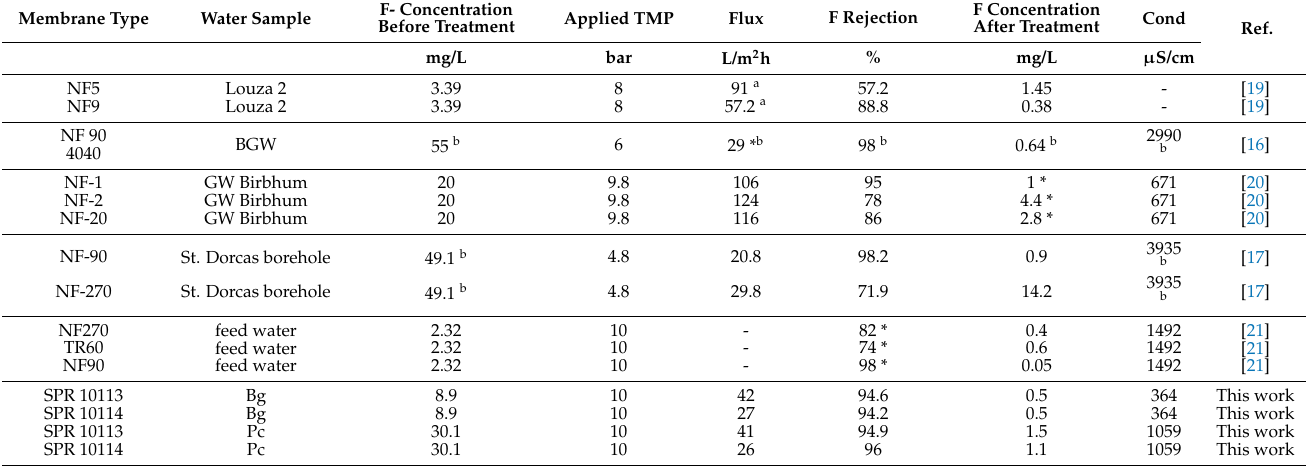
Table 3. Comparative table on the treatment of F-contaminated groundwaters using NF membrane processes. Membrane Type Water